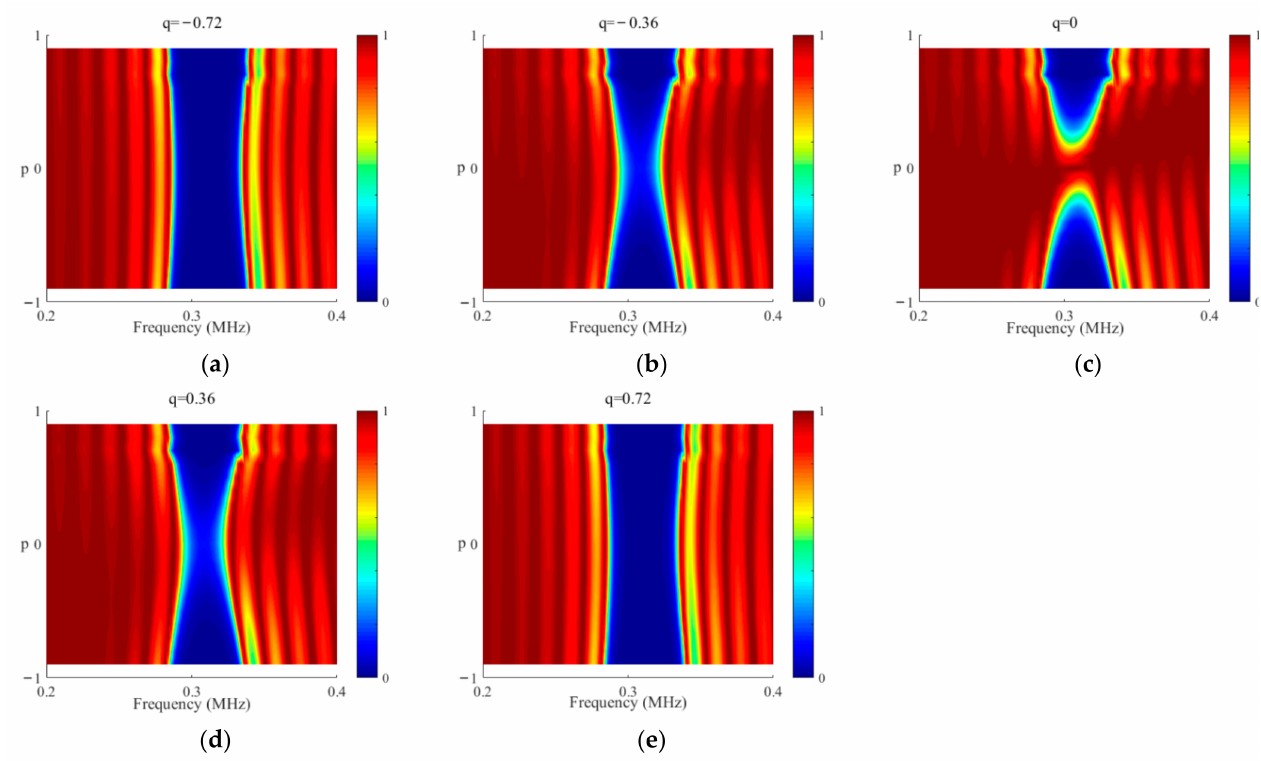
Figure 3. The TS through the PC plates with different parameters p and q . ( a ) q = − 0.72, ( b ) q = − 0.36, ( c ) q = 0, ( d ) q = 0.36, ( e ) q = 0.72. The band structures with negative q are the same as the band structures with the positive “ q ”, which leads to the same